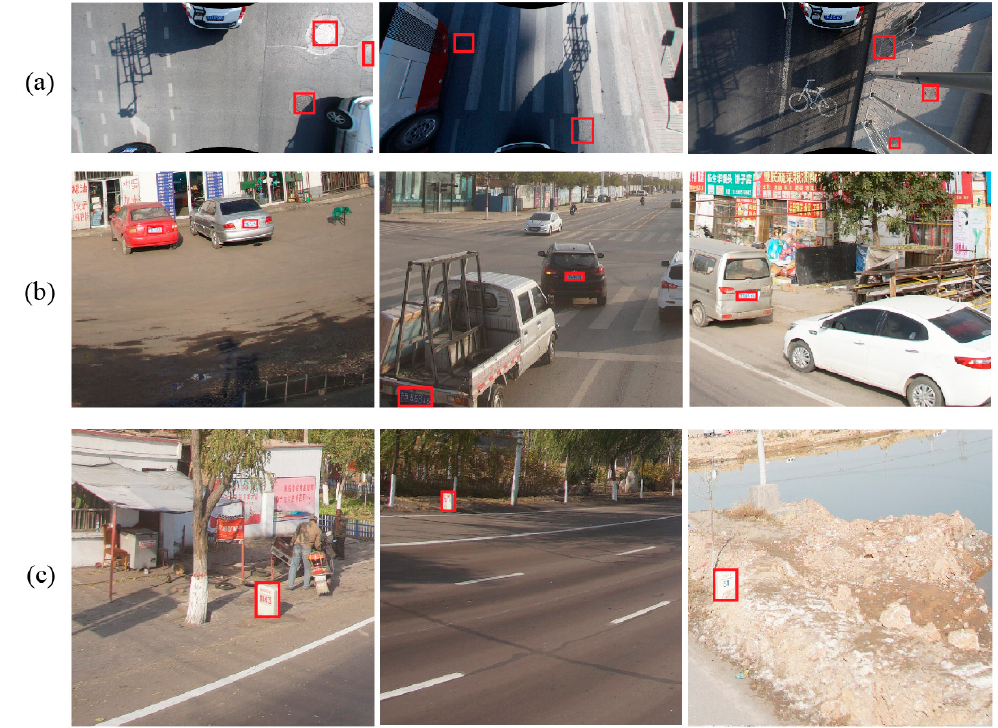
Figure 4. Examples of UED dataset. ( a ) Manhole covers; ( b ) license plates; ( c ) milestones.